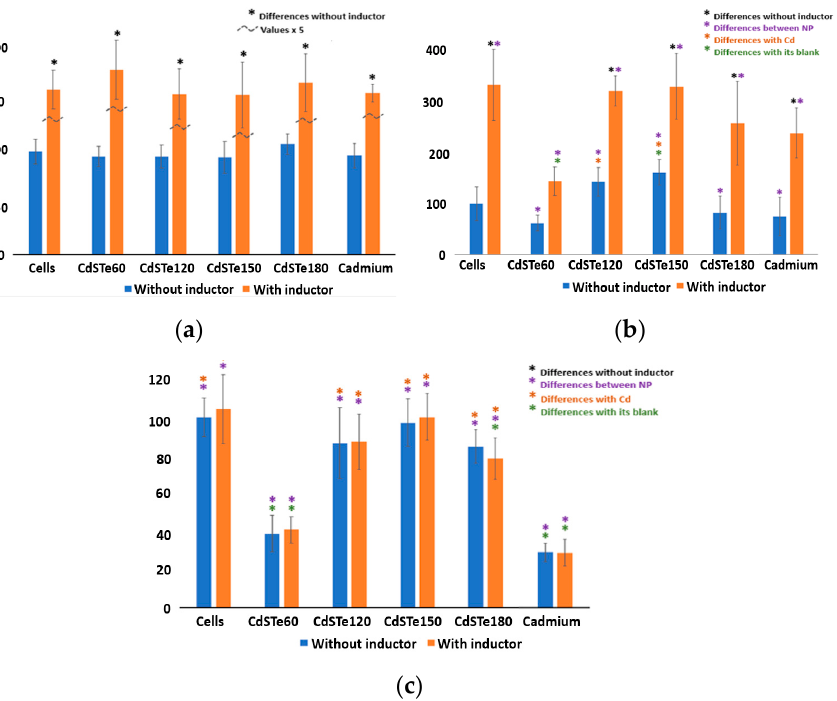
Figure 6. Responses of the ( a ) CYP 1A1, ( b ) CYP 1A2, and ( c ) CYP 3A4 isoenzymes to the HEP-G2 cells’ exposure to CdSTe QDs and Cd +2 with and without an inductor (omeprazole or rifampicin) using Luciferin-CEE, Luciferin-1A2, and Luciferin-PFBE as substrates, respectively.